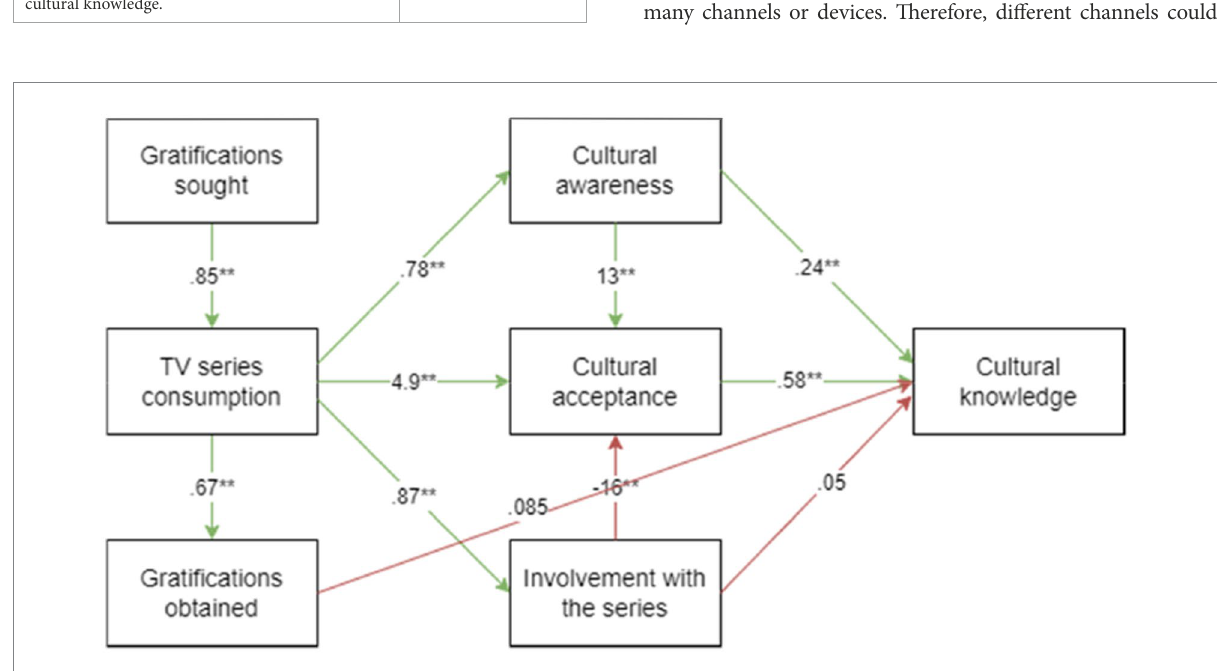
FIGURE 3 Results of research model. ** is 0.01 level of